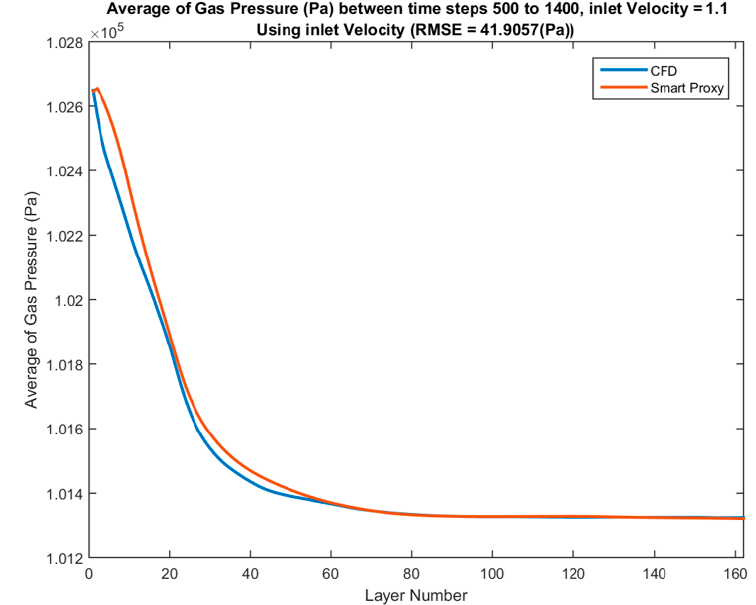
Figure 48. Spatial average profile of CFD and smart proxy results for gas pressure (Pa) averaged over time-steps 500 to 1400 for blind test condition of V in = 1.1 m/s.